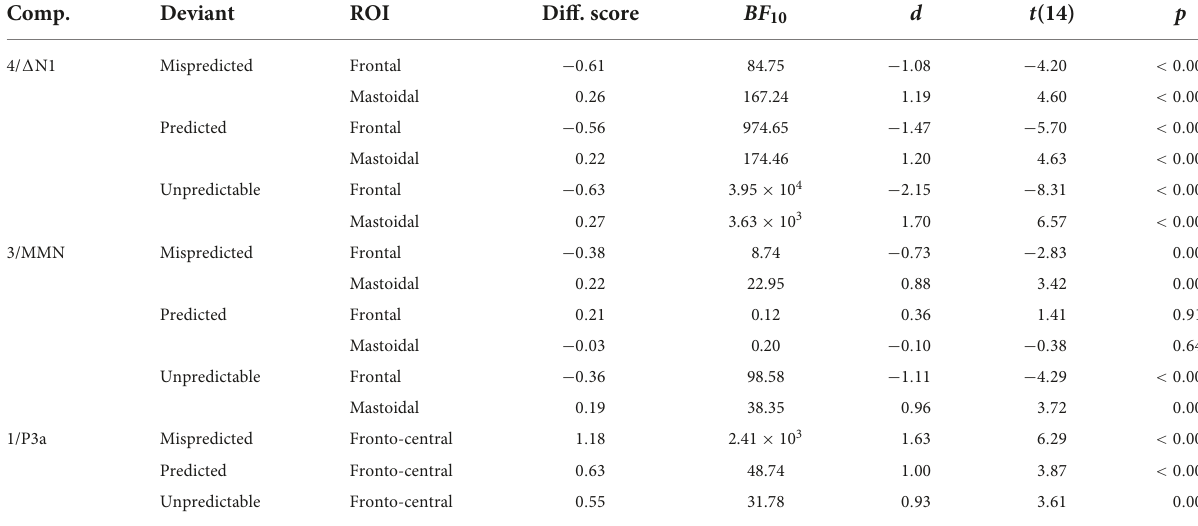
TABLE 1 Deviant minus standard difference component scores for the PCA components N1, MMN, and P3a, effect sizes (Cohen’s d ), and results of one-sided Bayesian and frequentist t -tests against baseline separately per deviant type and ROI.